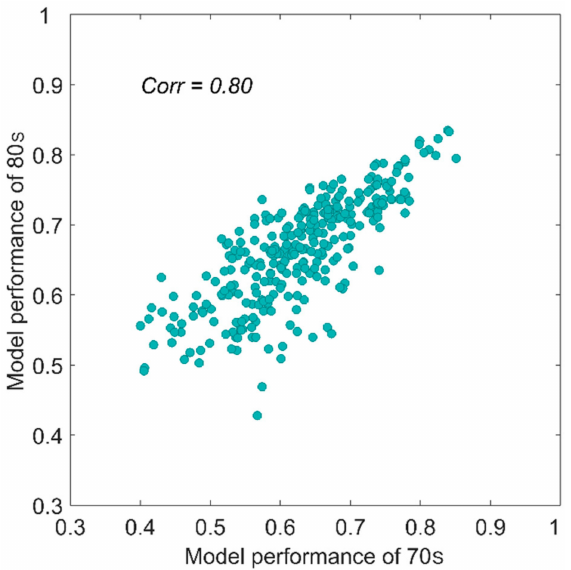
Figure 3. Comparison of NSBs for the validation period 1970–1979 and 1980–1989 by transferring model parameters from one-year data based model